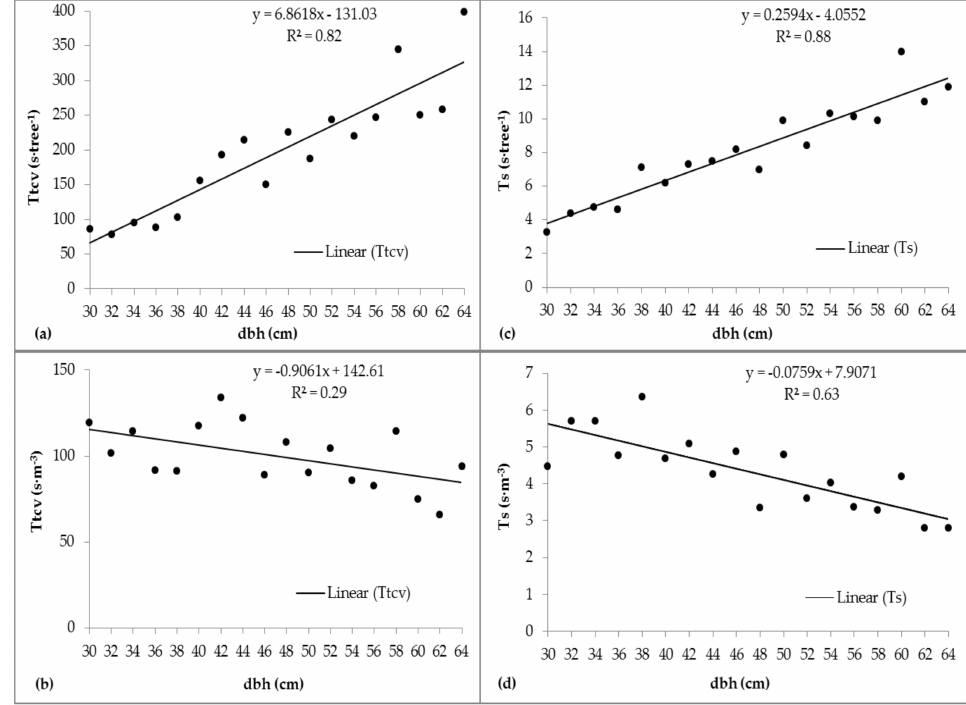
Figure 4. Work time consumed for delimbing ( a ) (s · tree − 1 ) and ( b ) (s · m − 3 )) and work time consumed for tree cross-cutting in the felling area ( c ) (s · tree − 1 ) and ( d ) (s · m − 3 )) depending on the